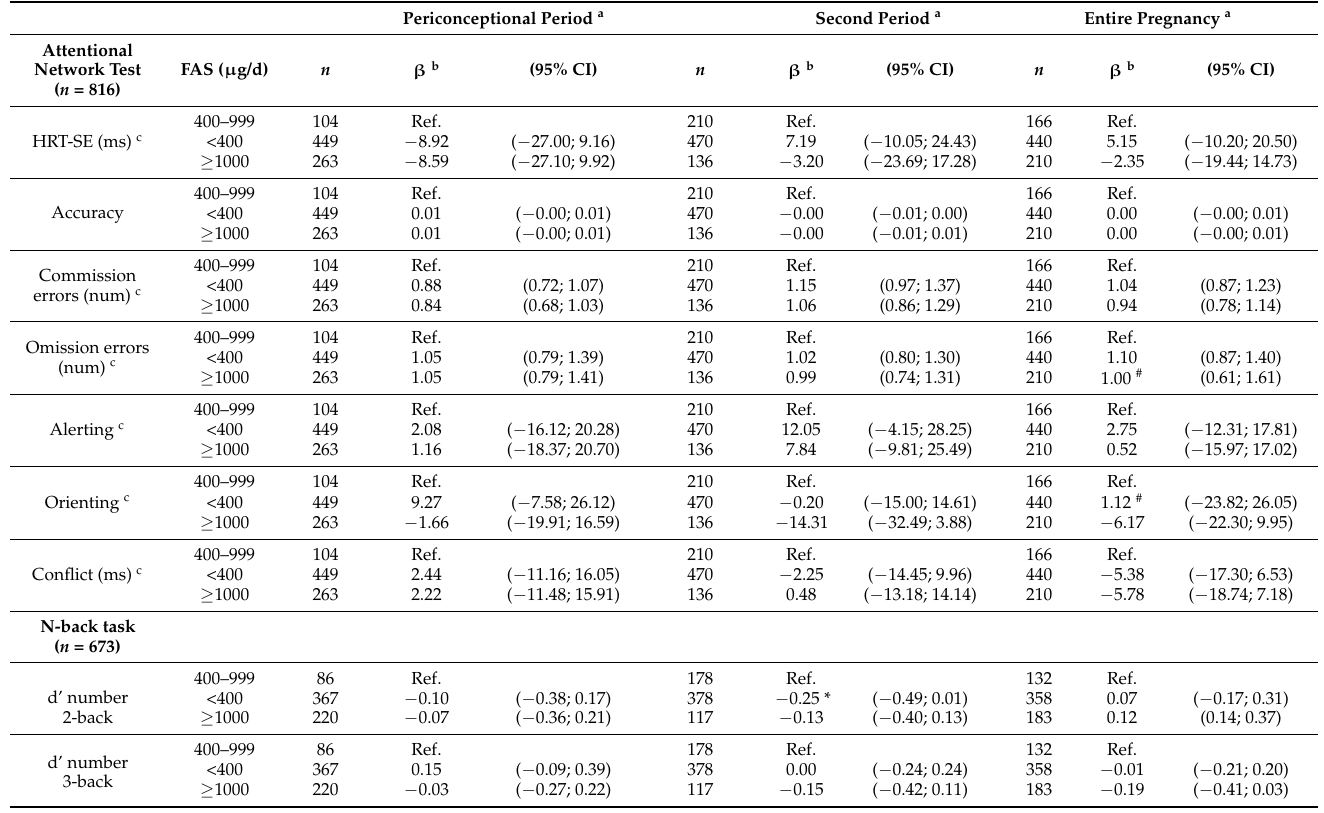
Table 4. Fully adjusted combined association between folic acid supplements (FAs) intake during pregnancy and attentional function in boys aged 7–9 y of INMA cohort study, Spain,